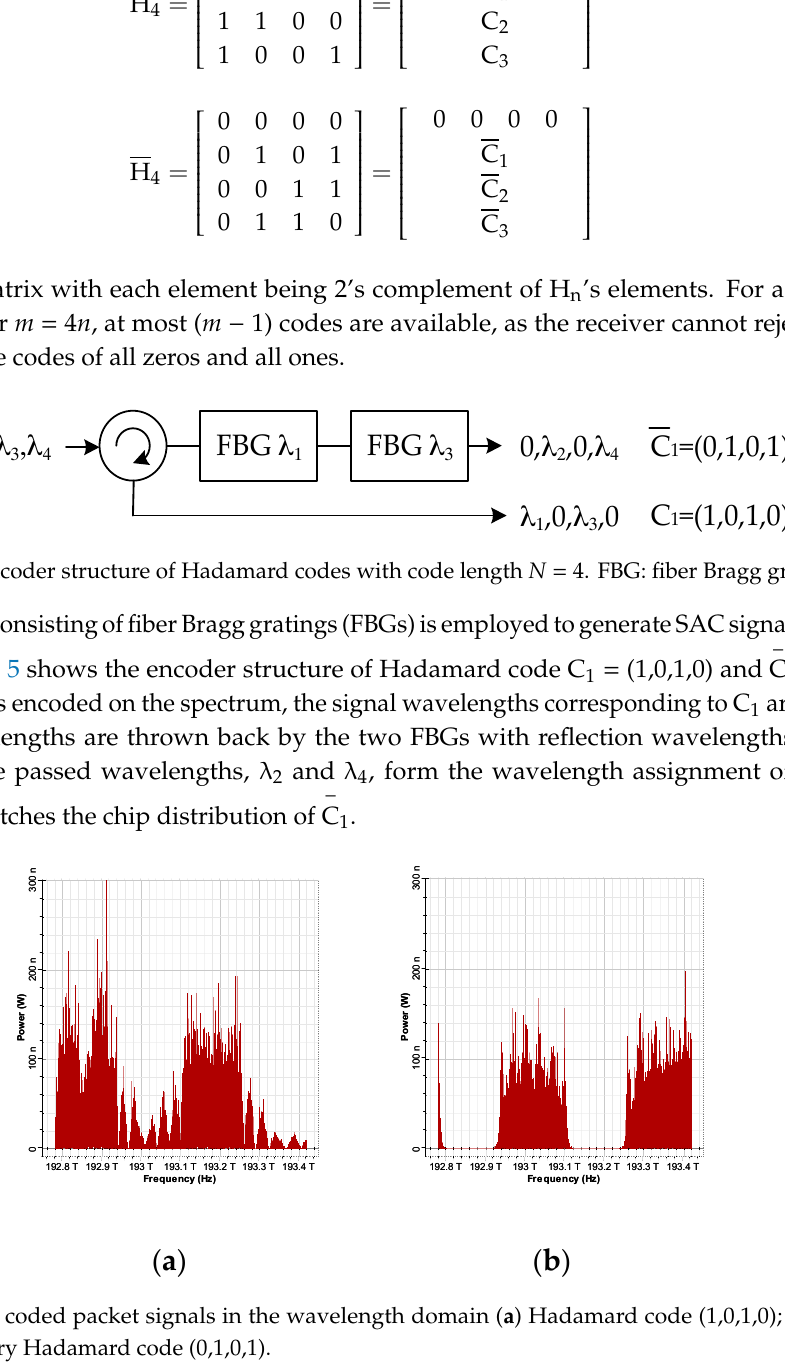
( c ) Figure 6. Time waveforms of ( a ) electrical payload sequence before optical modulation; ( b ) optical coded packets with TCK; and ( c ) demodulated payload sequence. 4. Buffering Performance Analysis In this section, we analyze the performance of the proposed buffer system. Effects of incoherent intensity noise and thermal noise in the photo-detectors for demodulating optical packets were investigated. The Gaussian approximation was proposed for quantifying the performance index of bit-error rate (BER). The variance of photo-current comes from the occurrence of spontaneous emission when a light signal is detected, which can be expressed as   